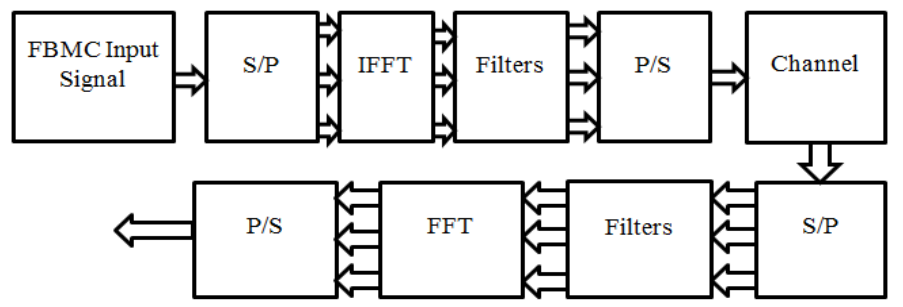
Figure 3. Structure of FBMC waveform.